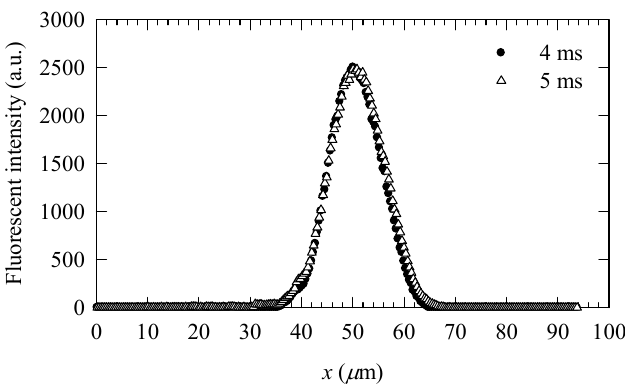
Figure 2. Schematic of the optical measurement system.